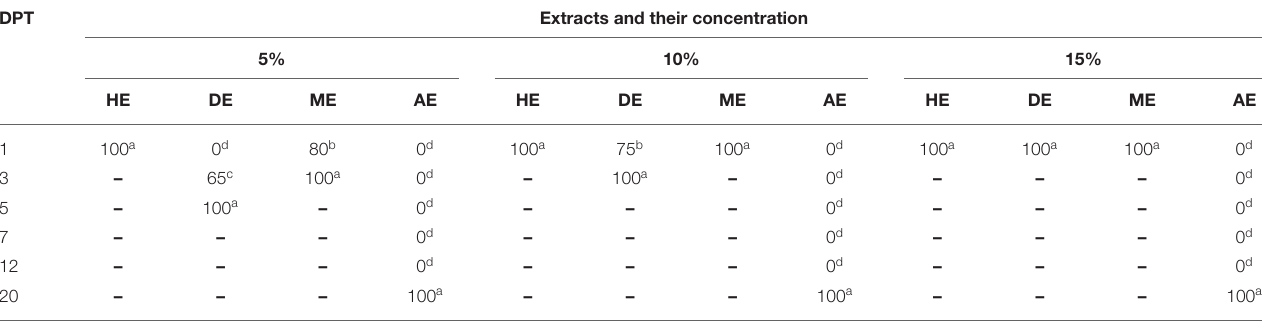
TABLE 6 | In vitro mortality rates of Hyalomma spp. larvae treated with 5, 10, and 15% of hexane, methanol, dichloromethane, and aqueous extracts emulsions of neem seeds. DPT